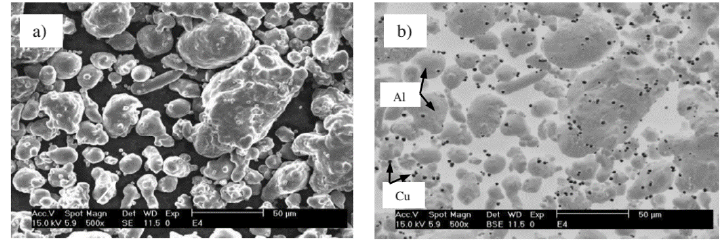
Figure 13. SEM micrographs of custom-developed Al-Cu powders ( a ) powder observed by secondary